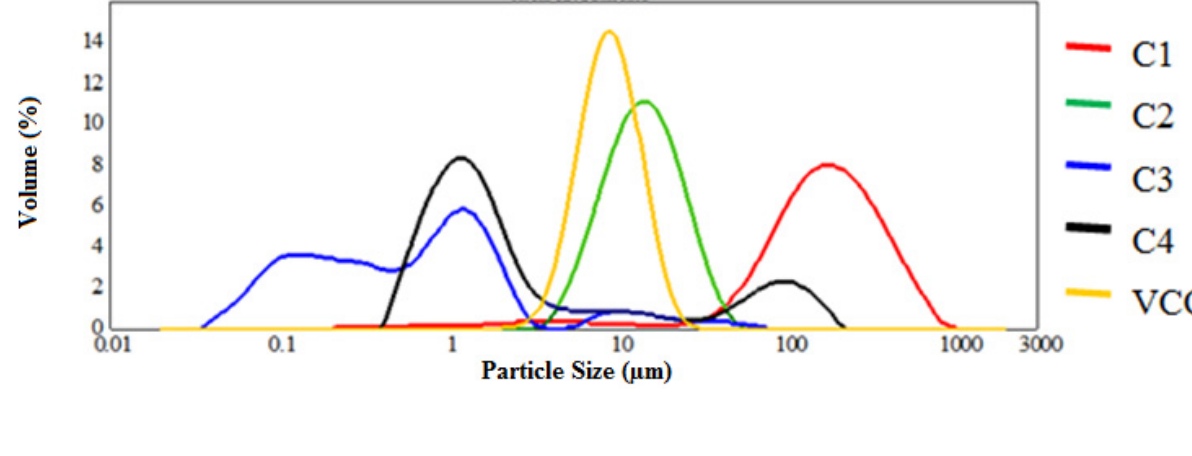
Figure 2. Droplet size distribution of commercial emulsion samples (C1, C2, C3, C4) and virgin coconut oil